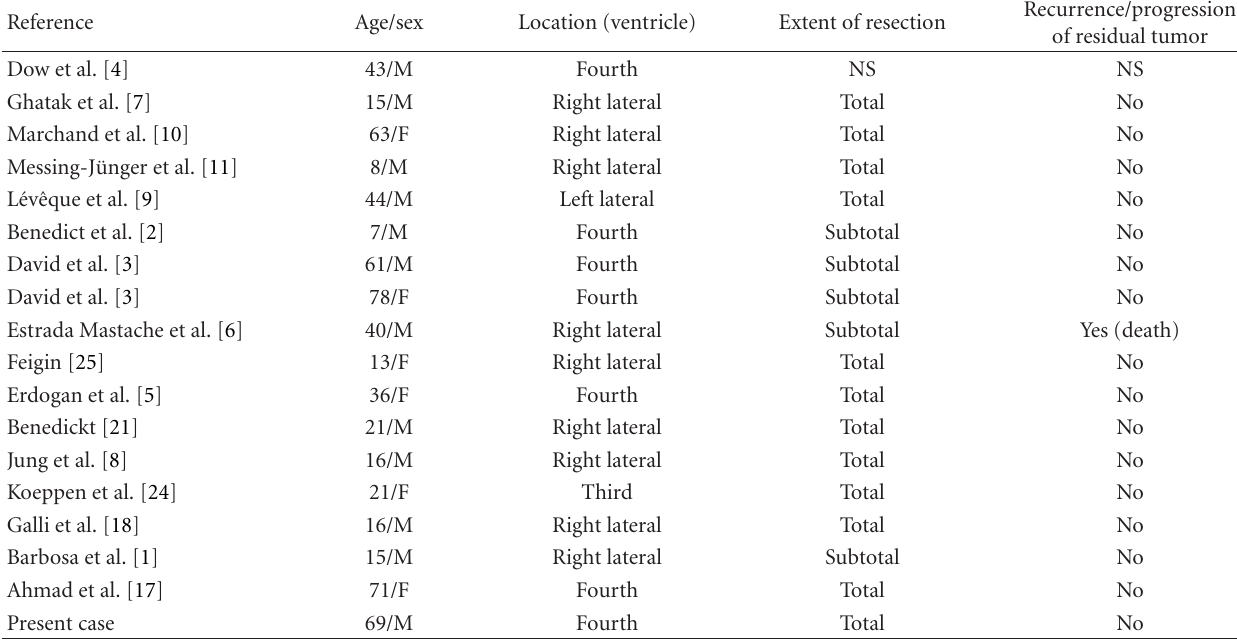
Table 1: Summary of reported cases of intraventricular